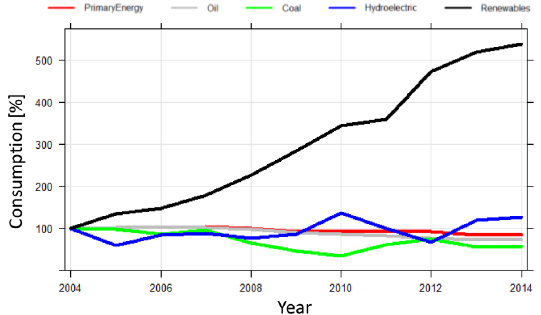
Figure 10. Annual (2004–2014) energy consumption for Spain (normalized to year 2004). Data from the Spanish Ministry of In- dustry (MINETUR,